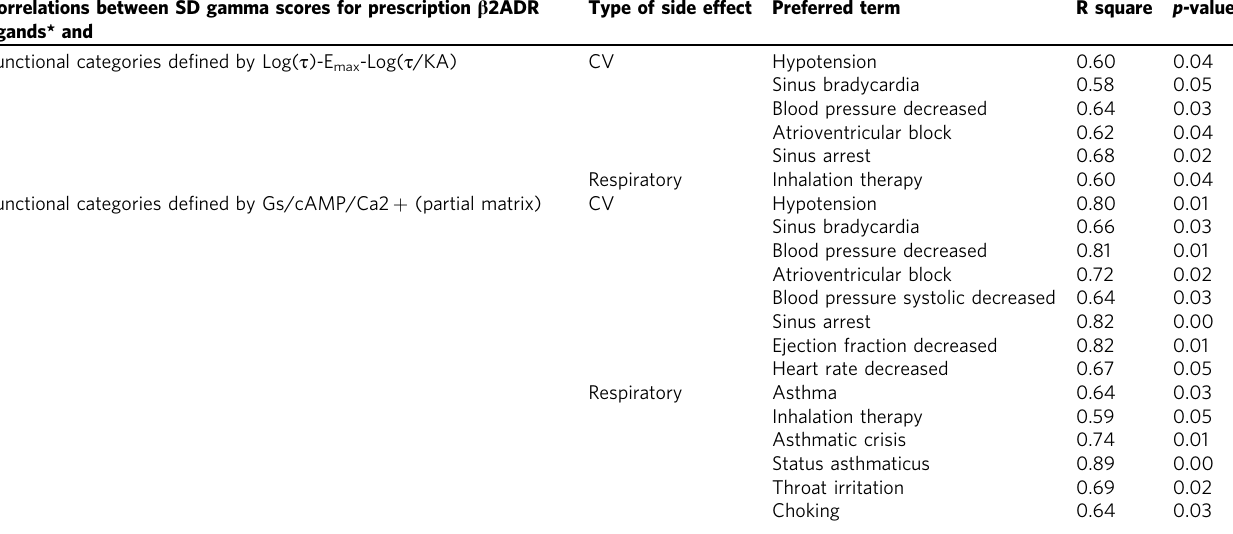
Type of side effect Preferred term R square p- value